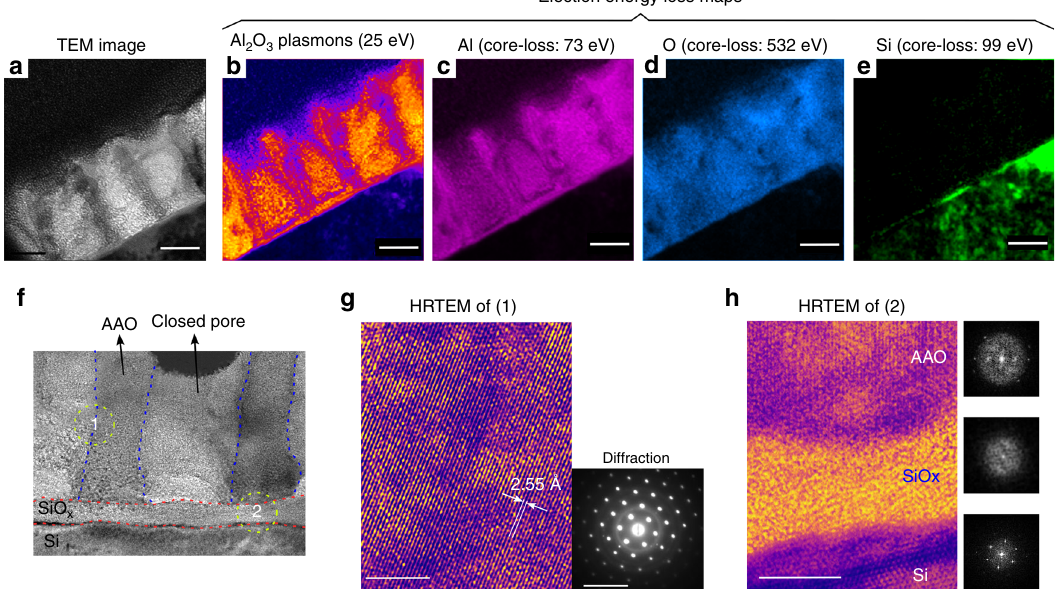
Fig. 4 Atomic structure. a – e TEM image and EELS (electron energy loss spectroscopy) from a cross-section of closed pores in am-AAO irradiated with low- fl ux 25 keV He + . The corresponding EELS maps are: plasmon-loss of Al 2 O 3 at 25 eV, Al core-loss (in Al 2 O 3 ) at 73 eV, Oxygen core-loss at 532 eV, and Si core-loss at 99 eV. It is concluded that the re-distributed material during the pore closure contains the same chemical components as the starting material (i.e.,: Aluminum and Oxygen with major Al-O bonds in the structure). The scale bar is 50 nm. f – h HRTEM (high-resolution TEM) images from a closed pore revealing crystallization am-AAO after irradiation, where fl ow of low-energy He + ions through thin am-AAO fi lms left behind increased order in the crystal structure at both pre-existing and closed-pore regions. Dashed lines in ( f ) are to approximately indicate the boundaries of pre-existing and newly-formed (closed pore) areas. h Lattice fringes in the crystalized am-AAO is obvious in Region 1 in both pre-existing and closed-pore areas (the scale bar is 5 nm). The inset shows selected area electron diffraction (the scale bar is 10 1/nm). h Region 2, is the atomic structure at the interface of the materials (Si substrate, natural SiO x oxide layer, and AAO superstrate), in which: lattice fringes in Si substrate are (100) planes; SiO x layer remains amorphous after irradiation; AAO shows lattice fringes after irradiation (also see FFT images of each area). The scale bar is 10 nm. To see the high-resolution images